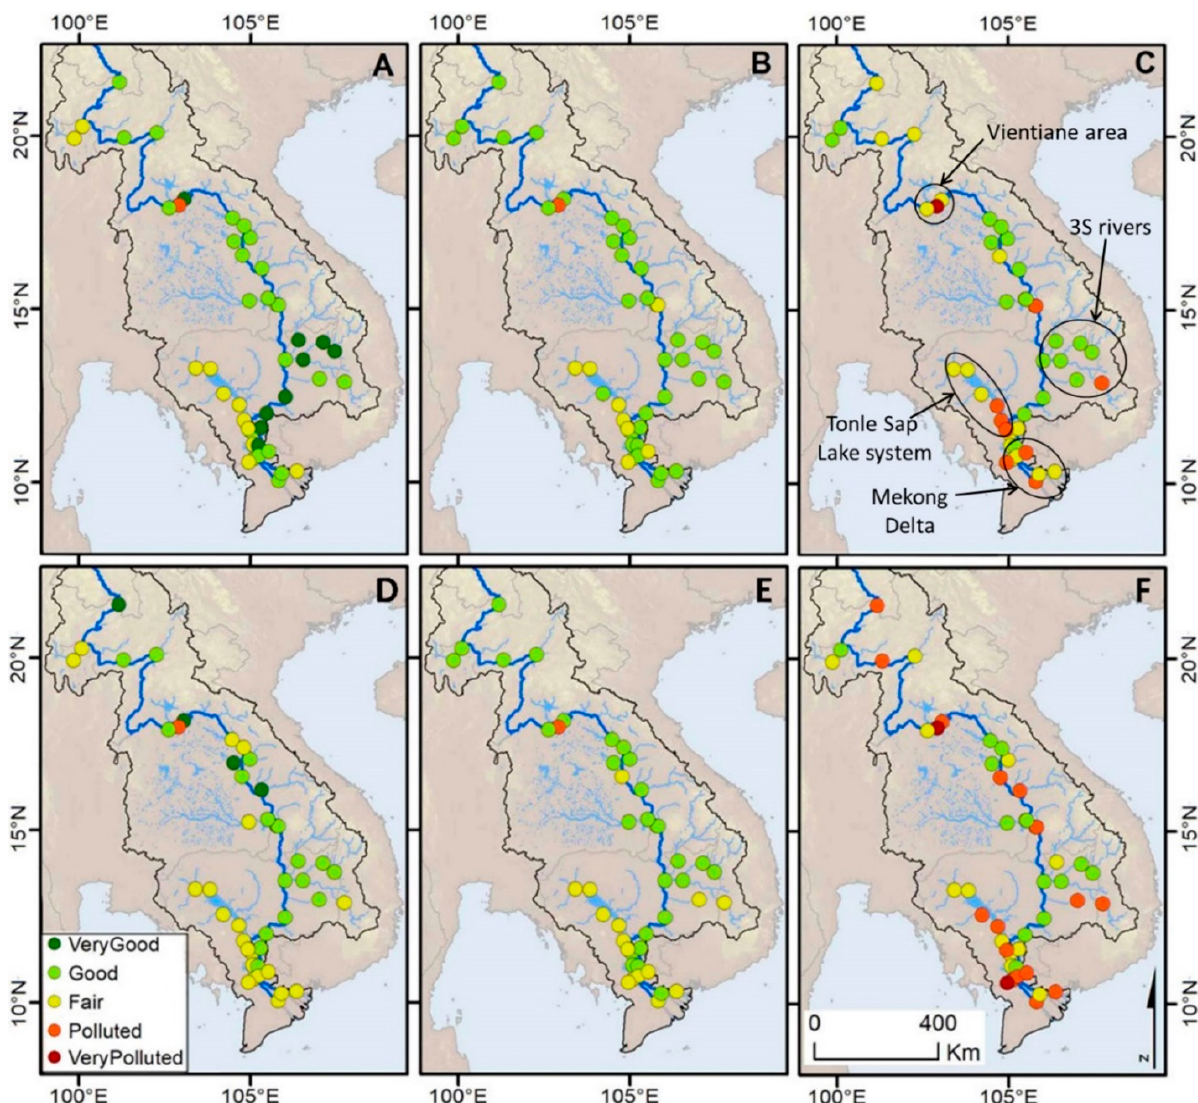
Figure 3. Abiotic water quality classification at each sampling site during the 2000s ( A – C ) and 2010s ( D – F ), based on the US-EPA ( A , D ), Basic Prati ( B , E ), and DO Prati ( C , F ) indices.